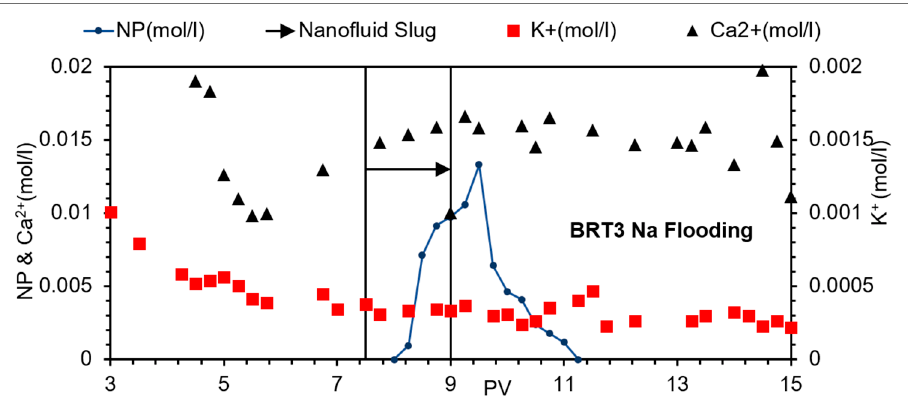
Figure 9. Effluent ion composition, BRT3 Na brine flooding. Figure 9. E ffl uent ion composition, BRT3 Na brine